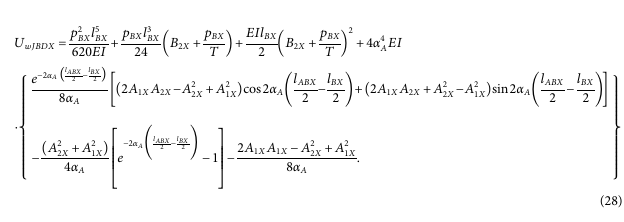
Frontiers in Earth Science |